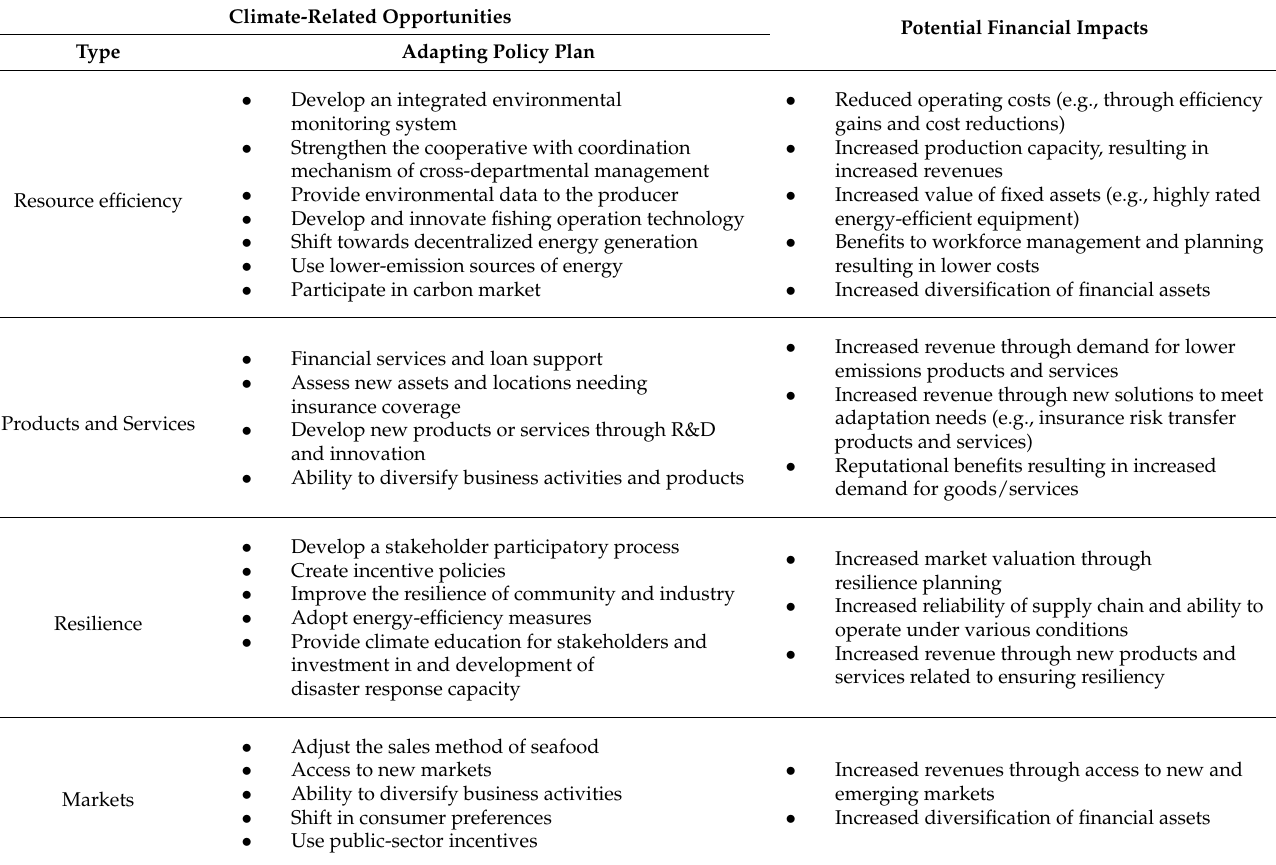
Table 6. Future climate-related opportunities and potential financial impacts for the marine fishery industry under climate